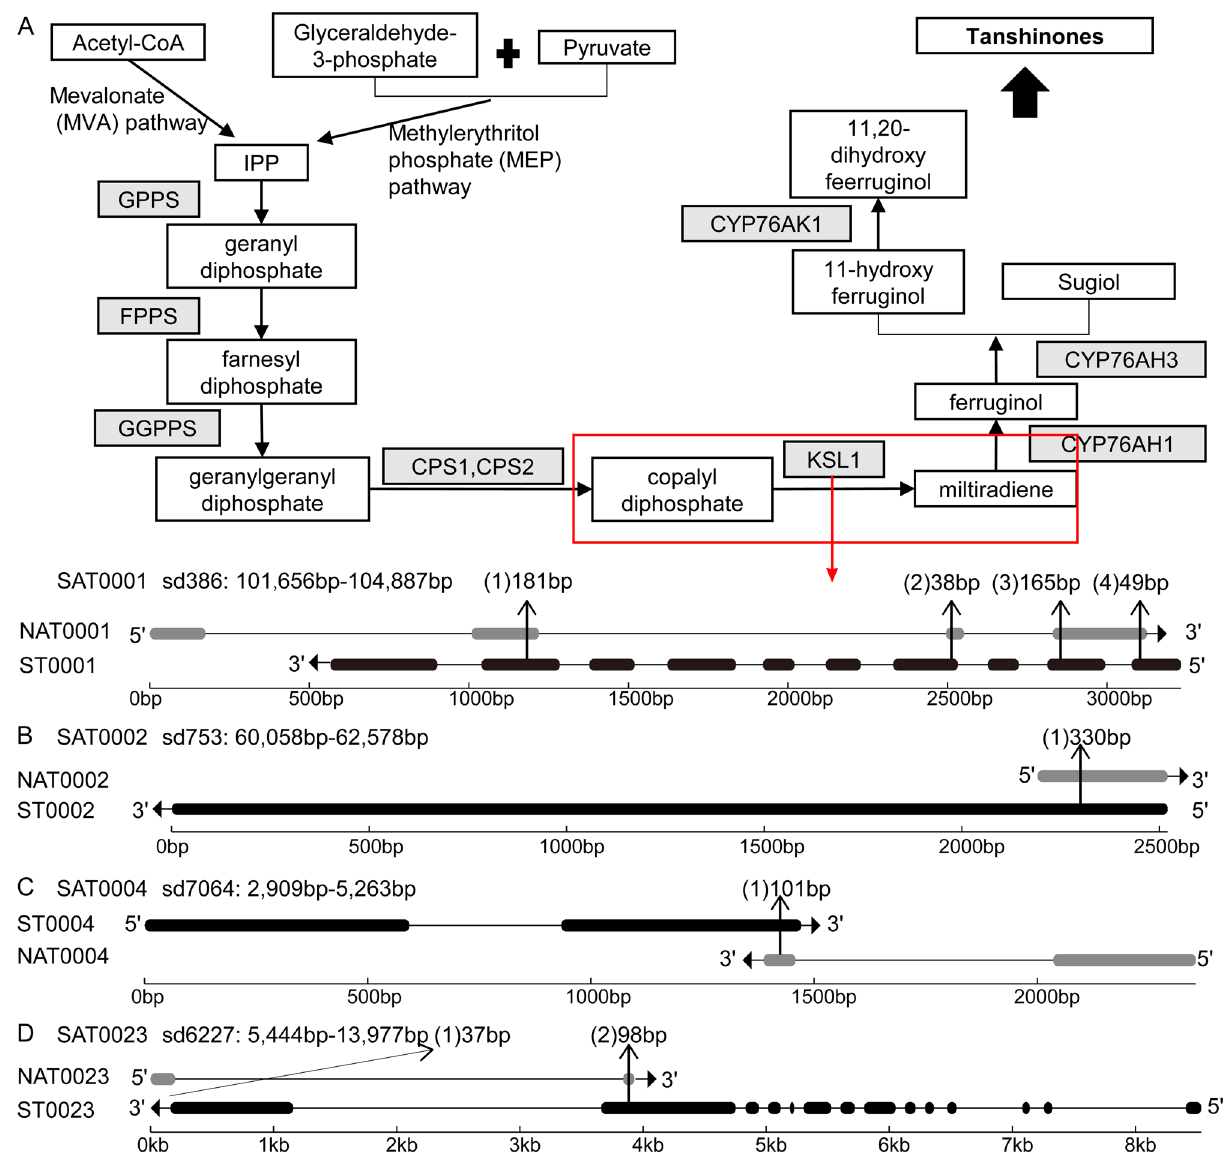
Figure 5. Gene structures of four SAT pairs. Panel ( A ) had two parts: the biosynthetic pathway of tanshinones in S. miltiorrhiza (above) and the gene structure of SAT0001 pairs (below). The enzymes were shaded in gray. The related ST and chemical compounds were highlighted with a white rectangle. Solid arrows indicated the reactions that have been experimentally validated, and dashed arrows indicated the hypothetical reactions. KSL1 that was encoded by ST0001 was marked by a red rectangle. In the area describing the gene structure, gray and black horizontal bars represent NAT and ST’s exons, respectively. The lines between bars represent introns. Arrows indicate the directions of transcription. The length of the overlapping region is marked above the structure. Similarly, panels ( B, C, D ) displayed the structures of SAT0002, SAT0004, and SAT0023 pairs in the same way as for SAT0001,